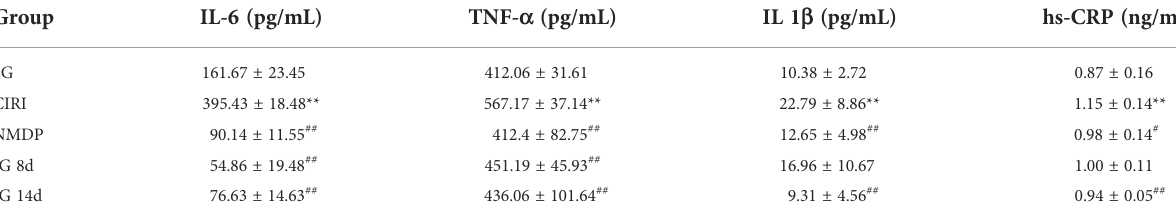
TABLE 2 In fl ammatory factor content in serum.